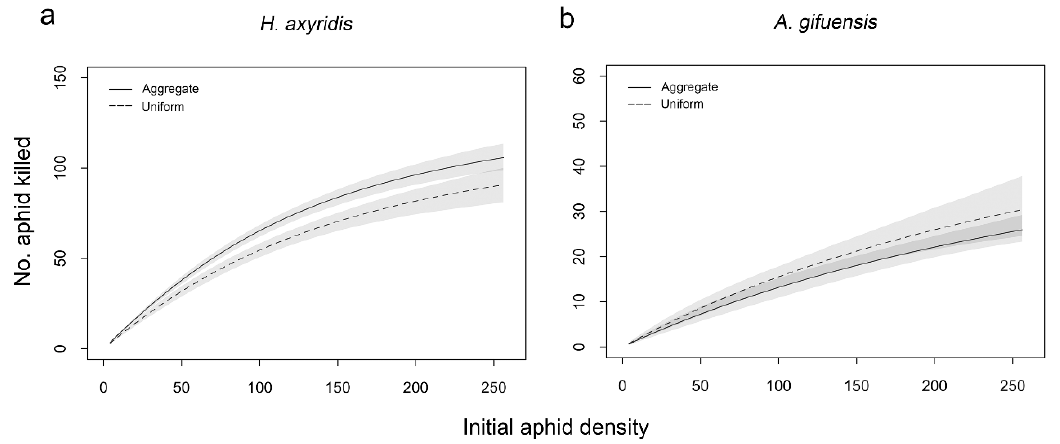
Figure 2. Functional response of individual Harmonia axyridis ( a ) or Aphidius gifuensis ( b ) to densities